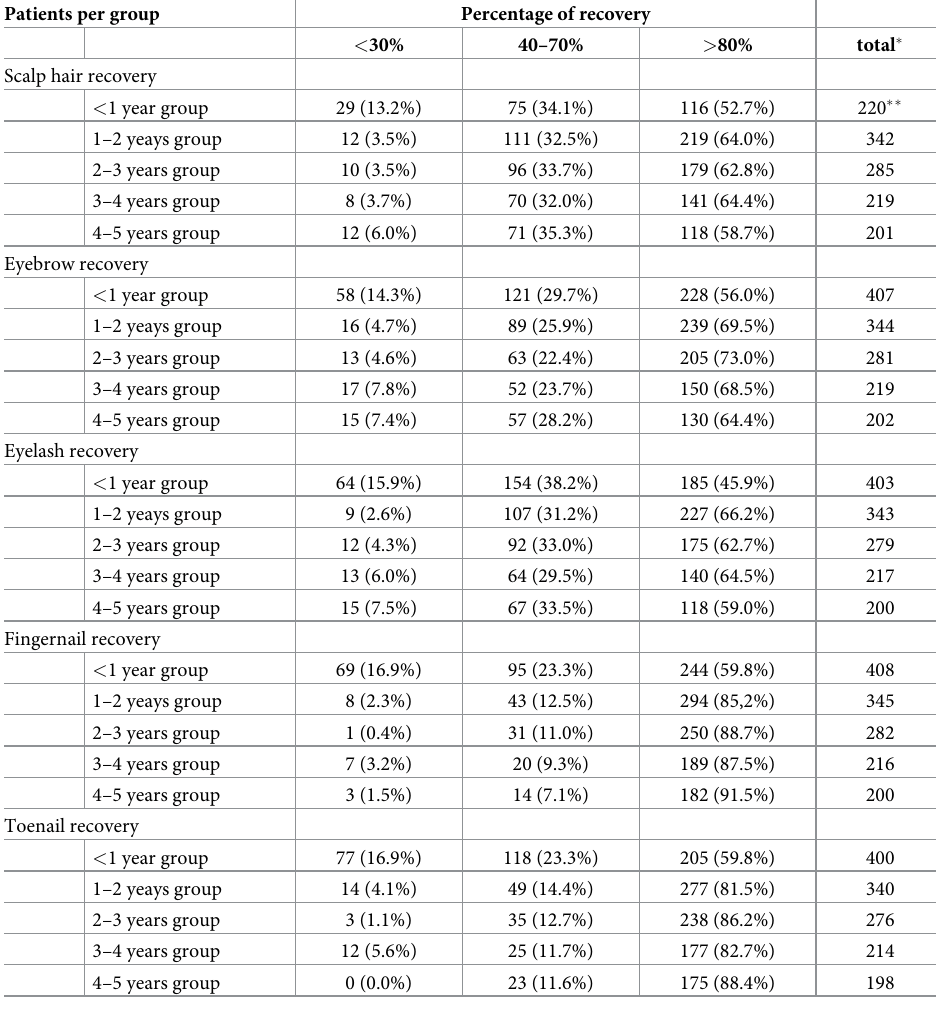
Table 5. Percentage of recovery by years after chemotherapy. Patients per